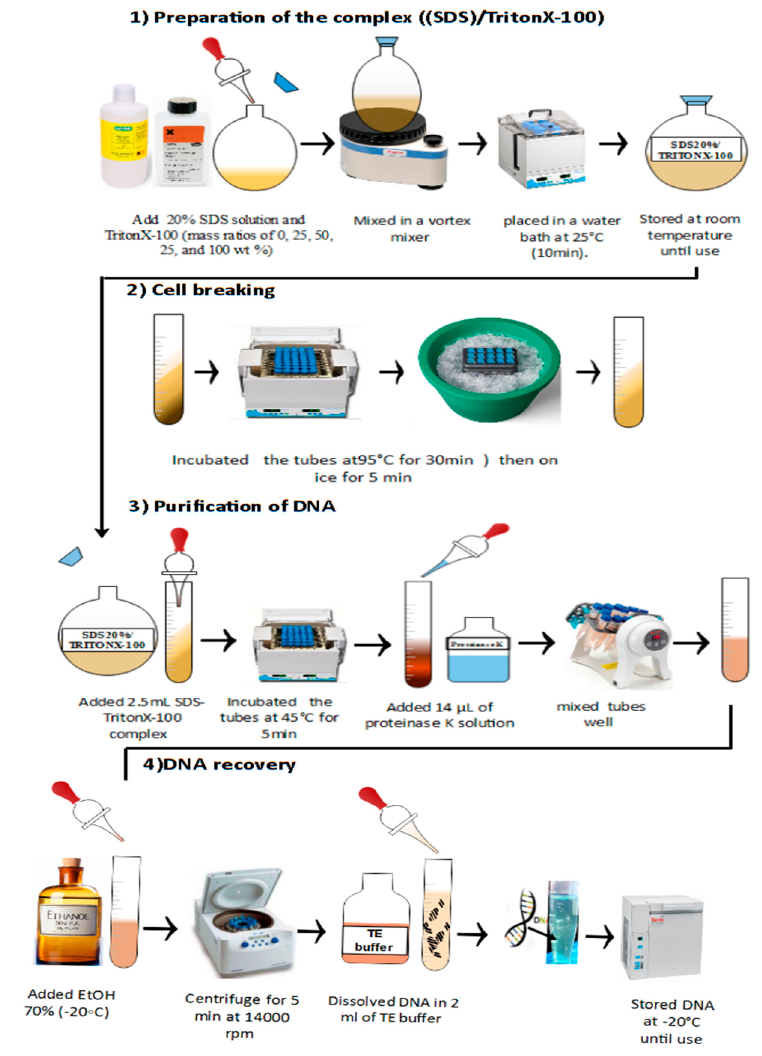
Figure 3. Schematic representation of the SDS 20%S/Triton X-100 method for the extraction and purification of DNA from Tetrahymena pyriformis .